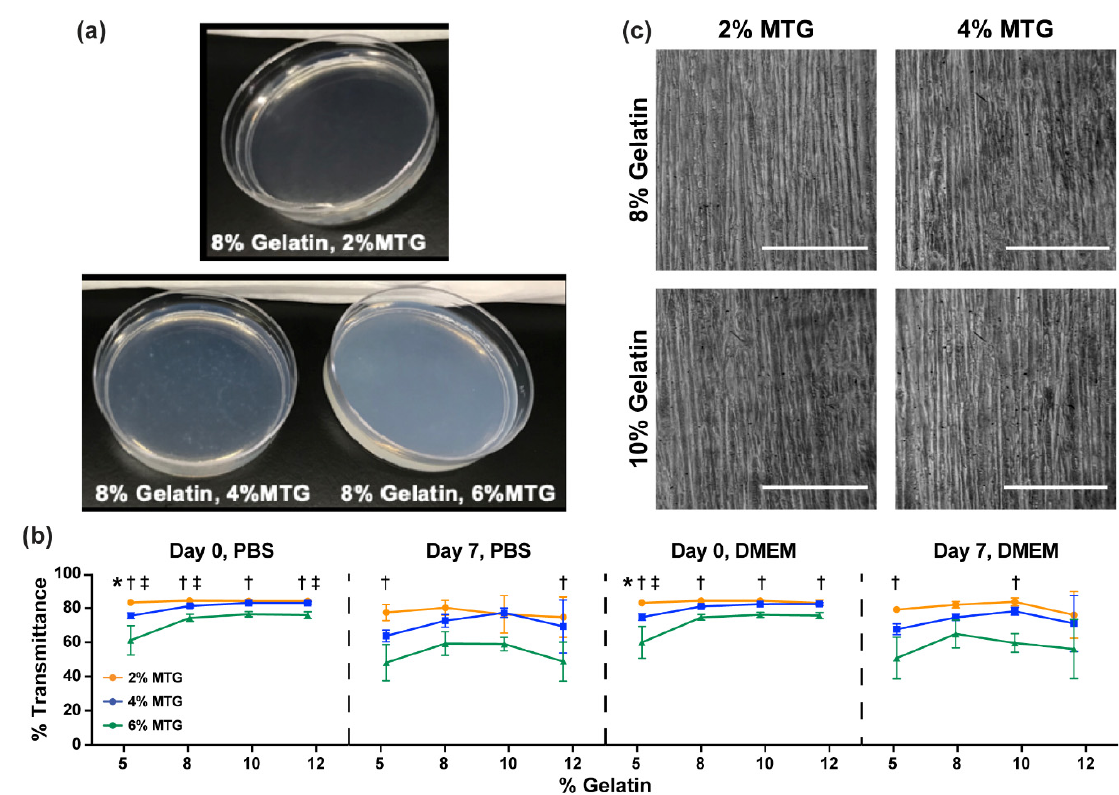
Figure 5. ( a ) Photographs of 8–2, 8–4, and 8–6 hydrogels on Day 0. ( b ) Percent transmittance of hydrogels in the indicated conditions. Bars indicate standard deviation, n = 4. * indicates p < 0.05 between 2% and 4% MTG, † indicates p < 0.05 between 2% and 6% MTG, and ‡ indicates p < 0.05 between 4% and 6% MTG within the same gelatin concentration, based on two-way ANOVA and Tukey’s multiple comparison test. ( c ) Images of C2C12 myotubes aligned on micromolded gelatin hydrogels with the indicated formulations. Scale bar: 200 µm.